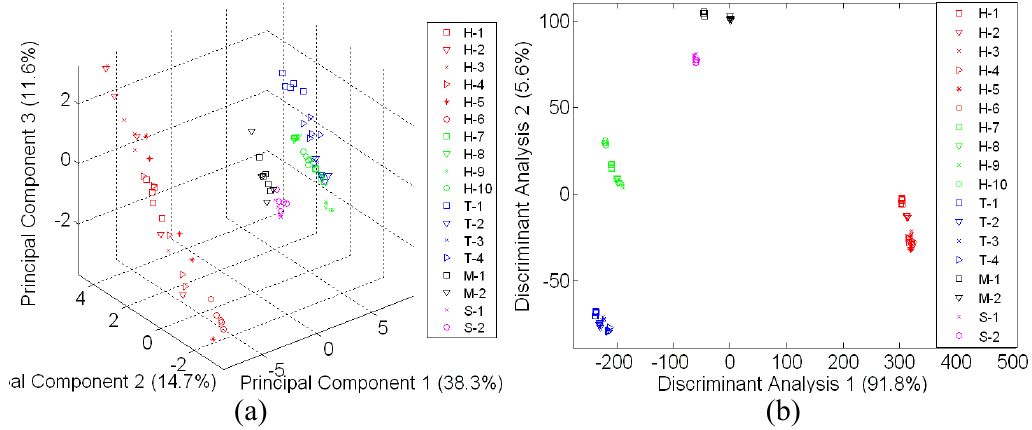
Figure 9. A global map of e-tongue assessment on of 18 different honey, sugar and adulterated samples ( a ) Using PCA and ( b ) Using LDA.